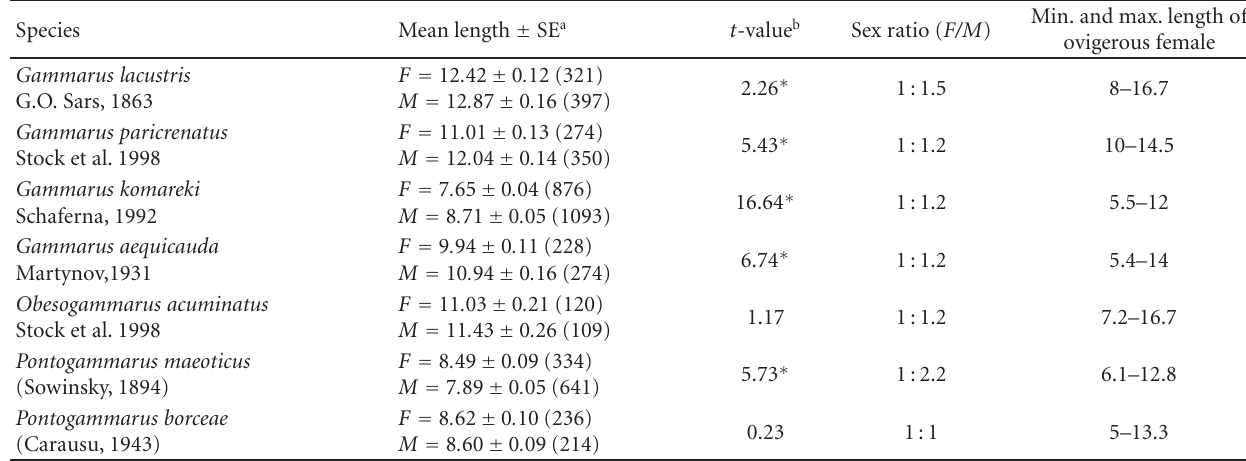
Table 2: Mean length of male and female specimens for each species.